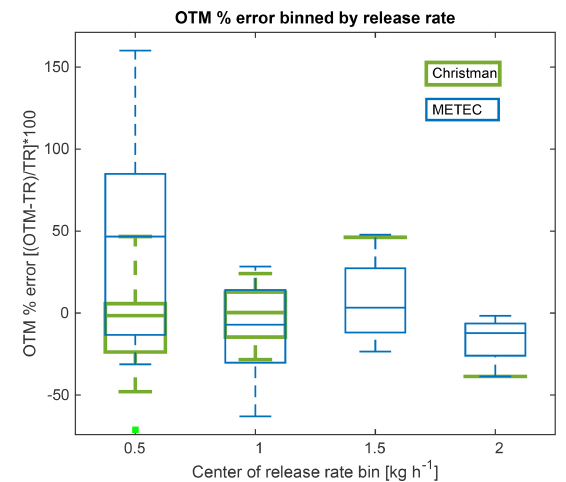
Figure 5. Box plot of METEC and Christman OTM 33A release errors binned by release rate. The rectangle contains the median value, while the edges represent the 25th and 75th percentiles. Box whiskers include the rest of the data (100% coverage). Positive per- cent error corresponds to OTM 33A overestimating the known re- lease